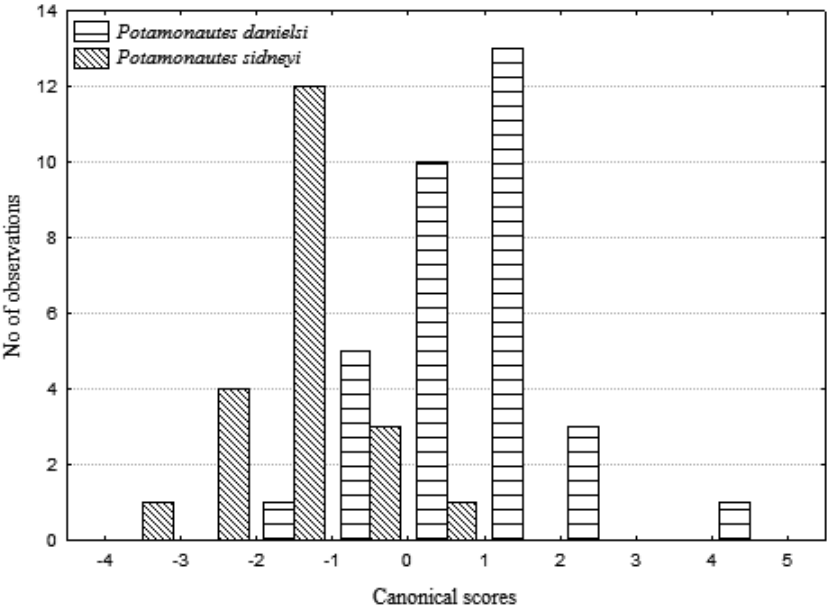
Figure 2. Histogram of canonical scores for P. danielsi sp. n. and P. sidneyi calculated from a discrimi- nant function analysis, based on six carapace and two right cheliped